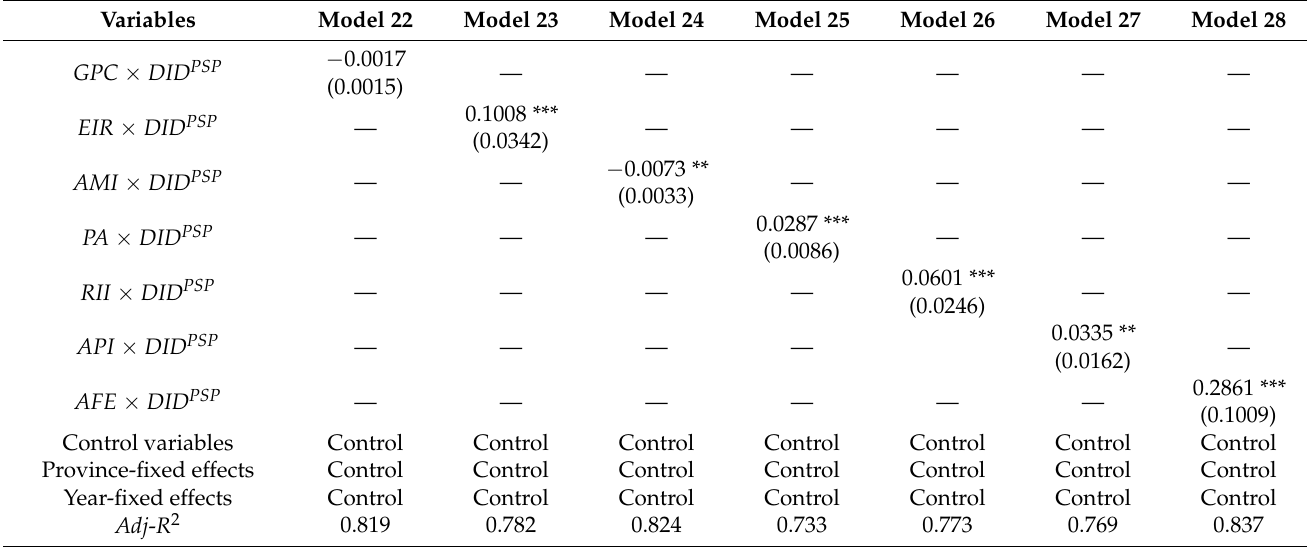
Table 7. Mechanism analysis results of the